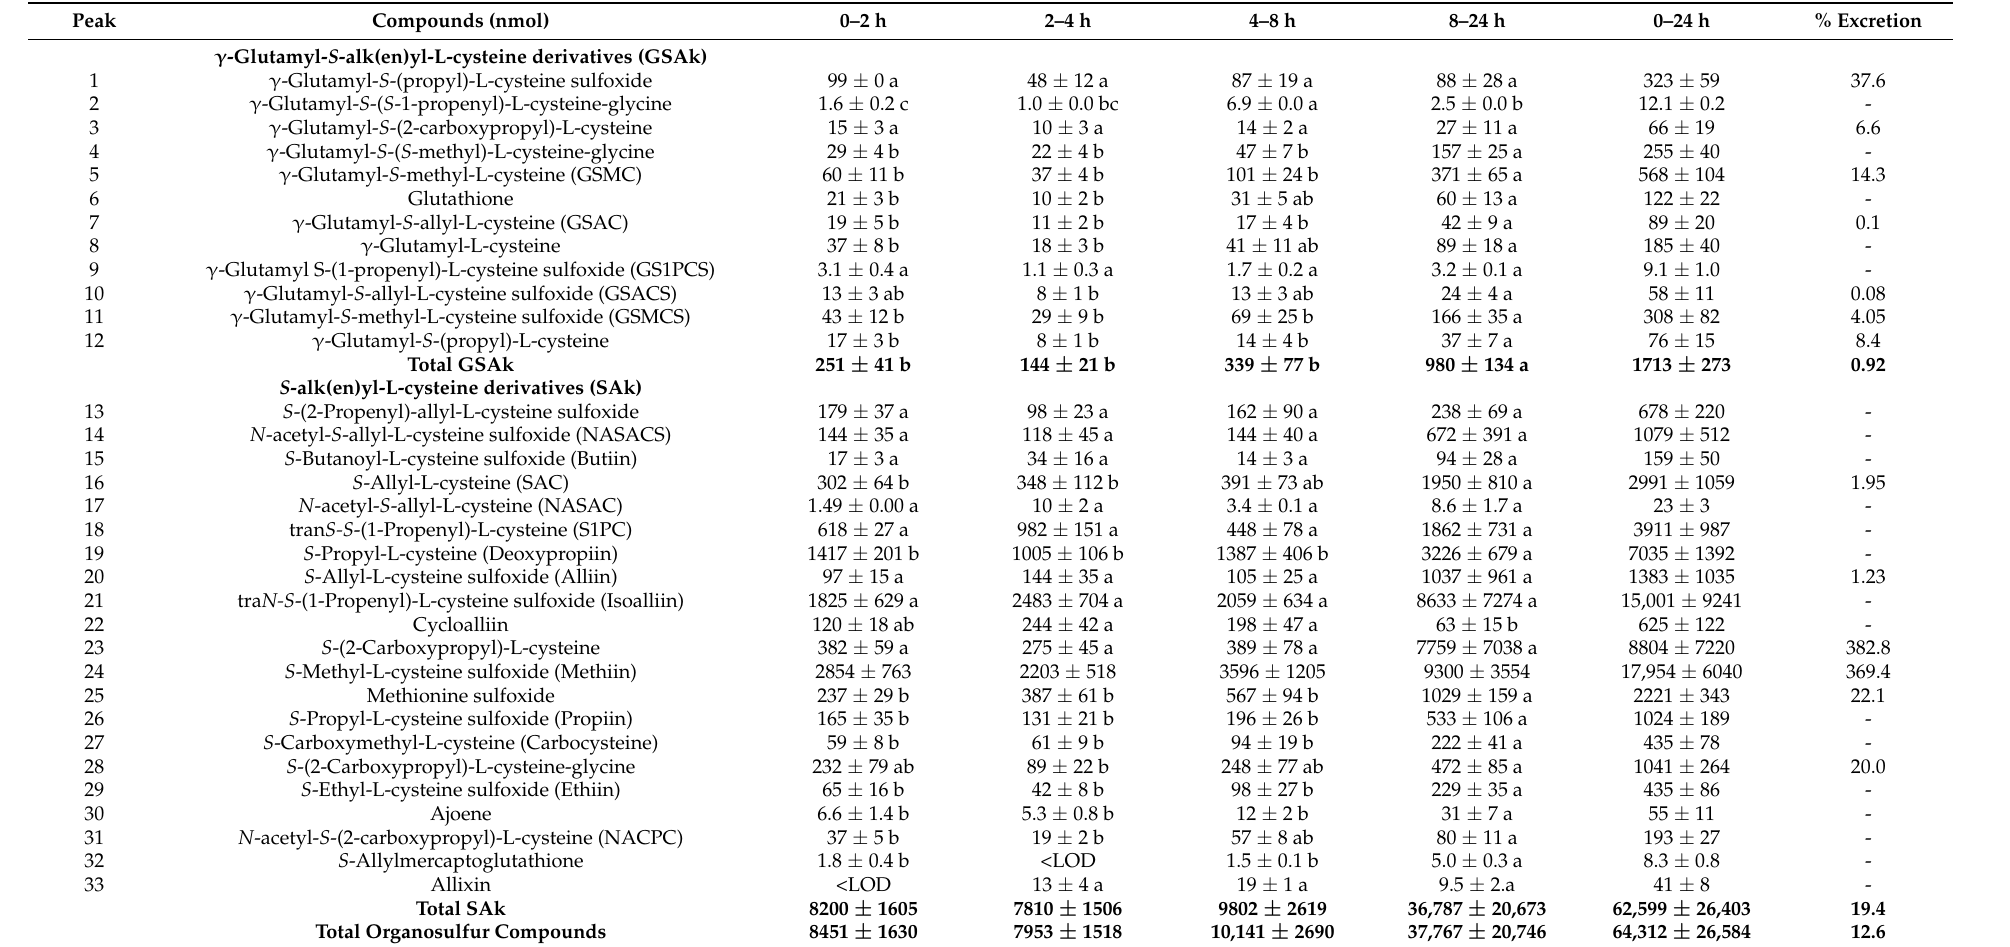
Table 3. Time-course profiles of the organosulfur compounds identified during urinary excretion after the intake of black garlic.